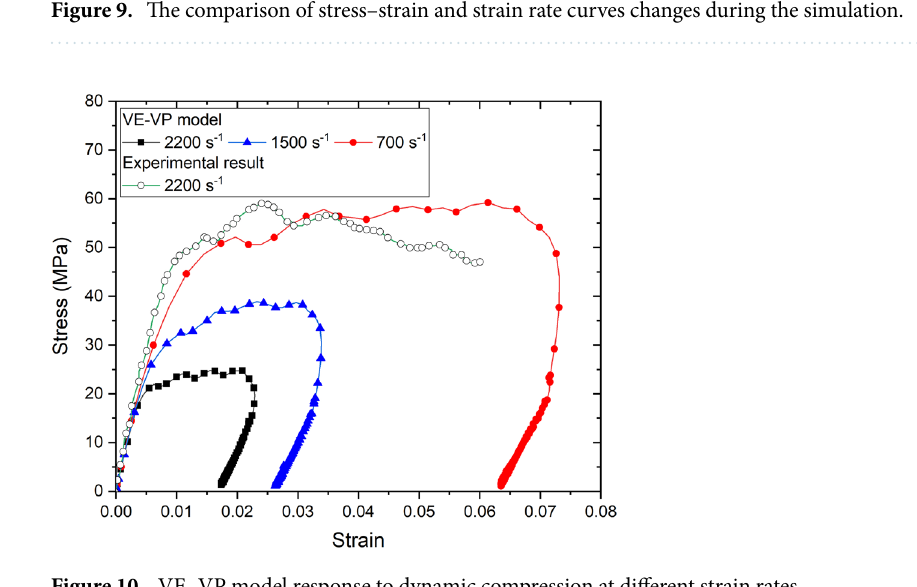
Figure 10. VE–VP model response to dynamic compression at different strain